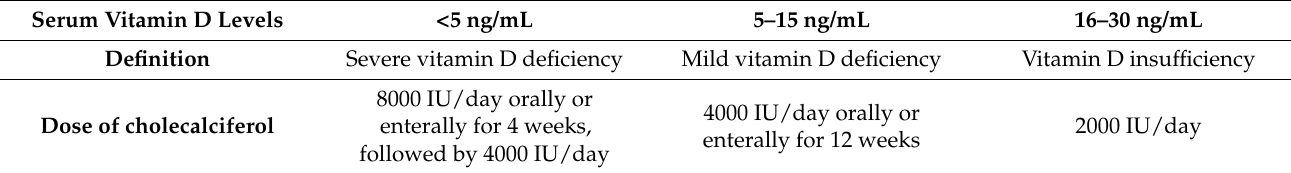
Table 2. Definition of vitamin D deficiencies and recommended supplementation with cholecalciferol. Serum Vitamin D Levels